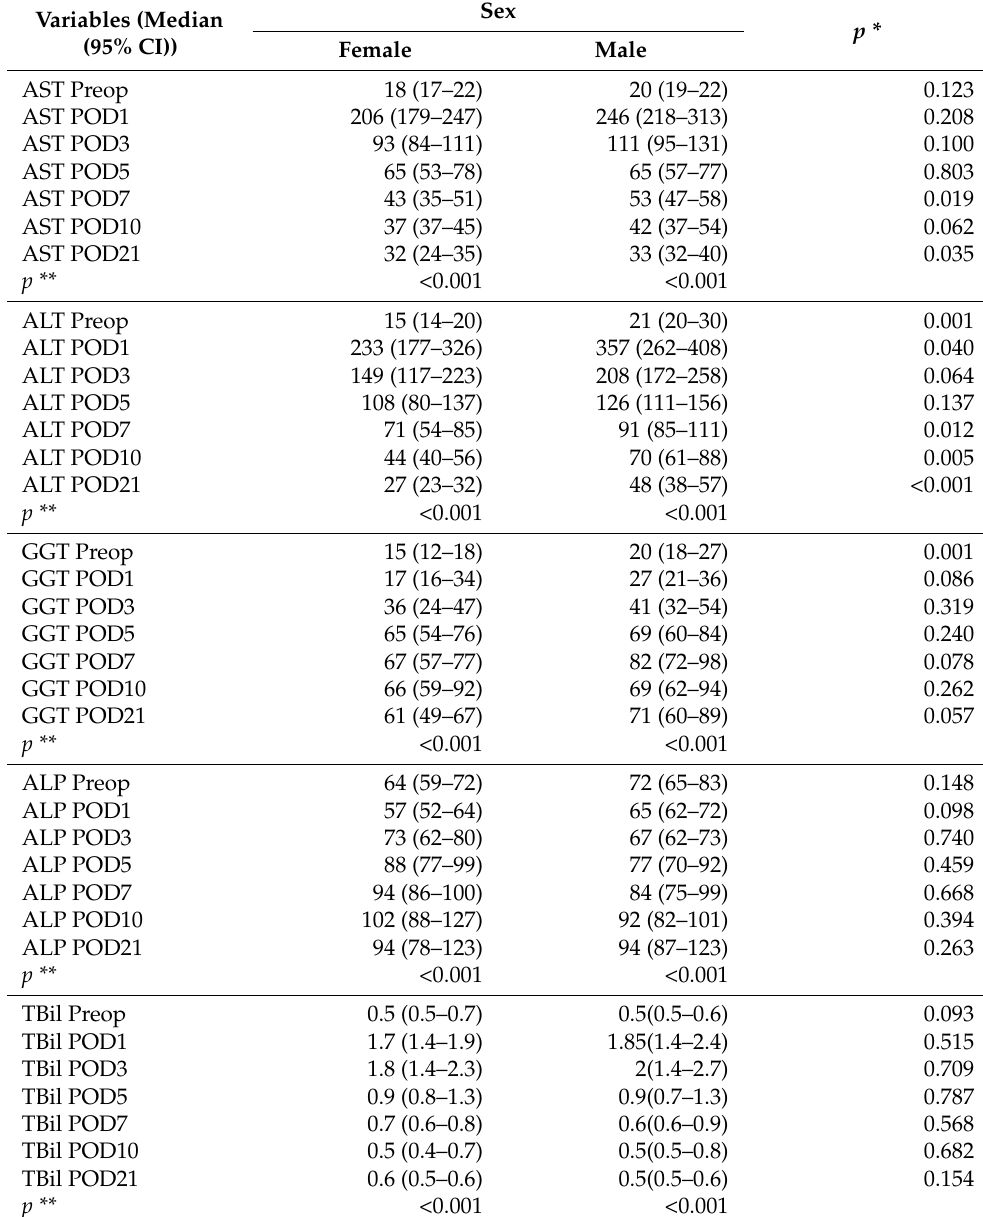
Table 7. Comparison of study subgroups created according to sex in terms of routine biochemical